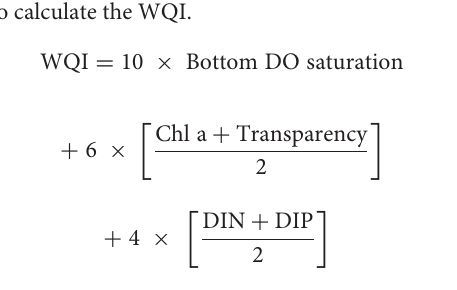
WQI. Standardized scores of each environmental variable were applied to calculate the